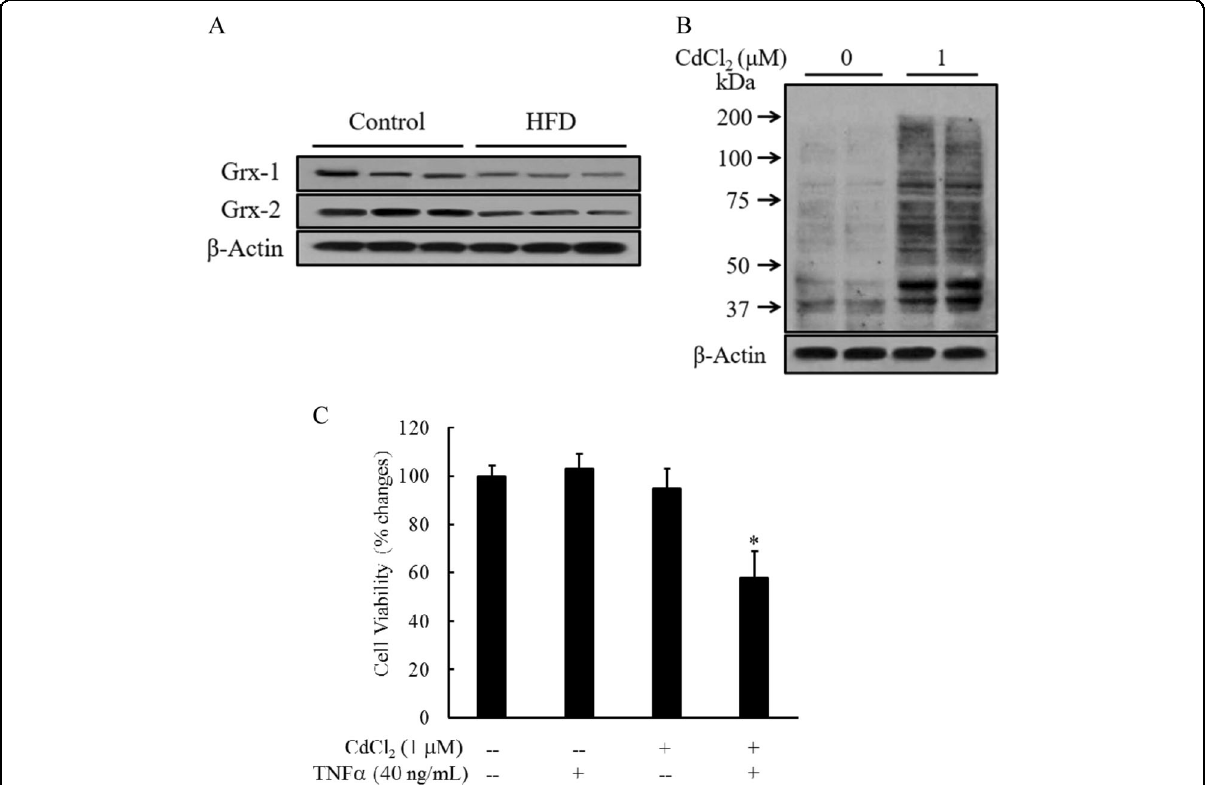
Fig. 8 Long-term HFD consumption reduces hepatic expression of glutaredoxins (Grxs). Male C57BL/6 mice were fed with either a control diet or high-fat diet (HFD) for 12 weeks. a Hepatic expression of Grx1 and Grx2. b Cdcl 2 , a chemical inhibitor of Grx, increased protein-SSG formation in hepatocytes. HepG2 cells were incubated with Cdcl 2 (1 μ M) for 16 h. Whole-cell lysates were collected and subjected to western blot analysis for the detection of the intracellular protein-SSG levels. c Cdcl 2 pretreatment sensitized hepatocytes to TNF α -induced cell death. HepG2 cells were pretreated with Cdcl 2 (1 μ M) for 2 h before TNF α (40 ng/mL) addition. Cell death was measured by LDH assay 16 h later. All values are expressed as the mean ± SD from three or more independent studies. * p < 0.01 versus untreated